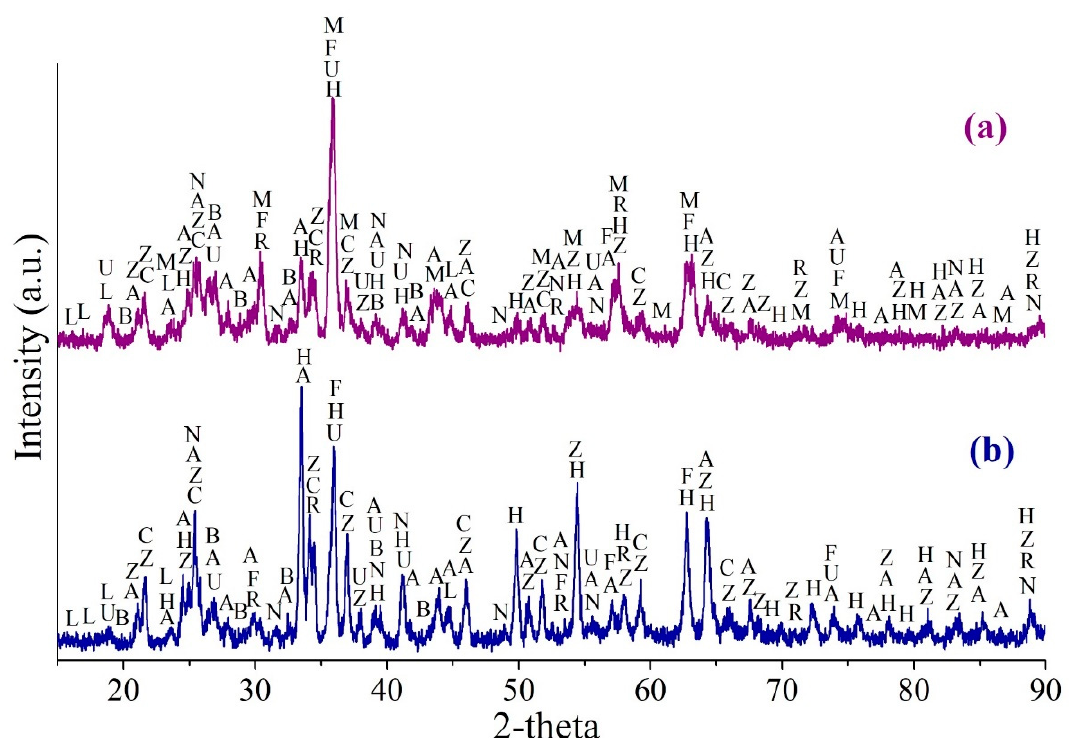
Figure 13. The XRD pattern of the ZPR sample roasted with the addition of 48% Fe 2 (SO 4 ) 3 ∙ 9H 2 O during 180 min at 600 ( a ) and 625 °C ( b ), where H— α -Fe 2 O 3 (hematite) (96–901–4881); M— γ -Fe 2 O 3 (maghemite) (96–152–8613); F—ZnFe 2 O 4 (96–151–3088); A—PbSO 4 (96–900–0653); U—ZnSO 4 ∙ H 2 O (96–900–9374); Z—ZnSO 4 (96–900–7445); L—CuSO 4 ∙ 5H 2 O (96–101–0528); C—CuSO 4 (96–231–0621); R—Ca 3 Al 2 (SiO 4 ) 3 (96–900–2680); N—CaSO 4 (96–500–0041); B—BaSO 4 (96–100–0038).